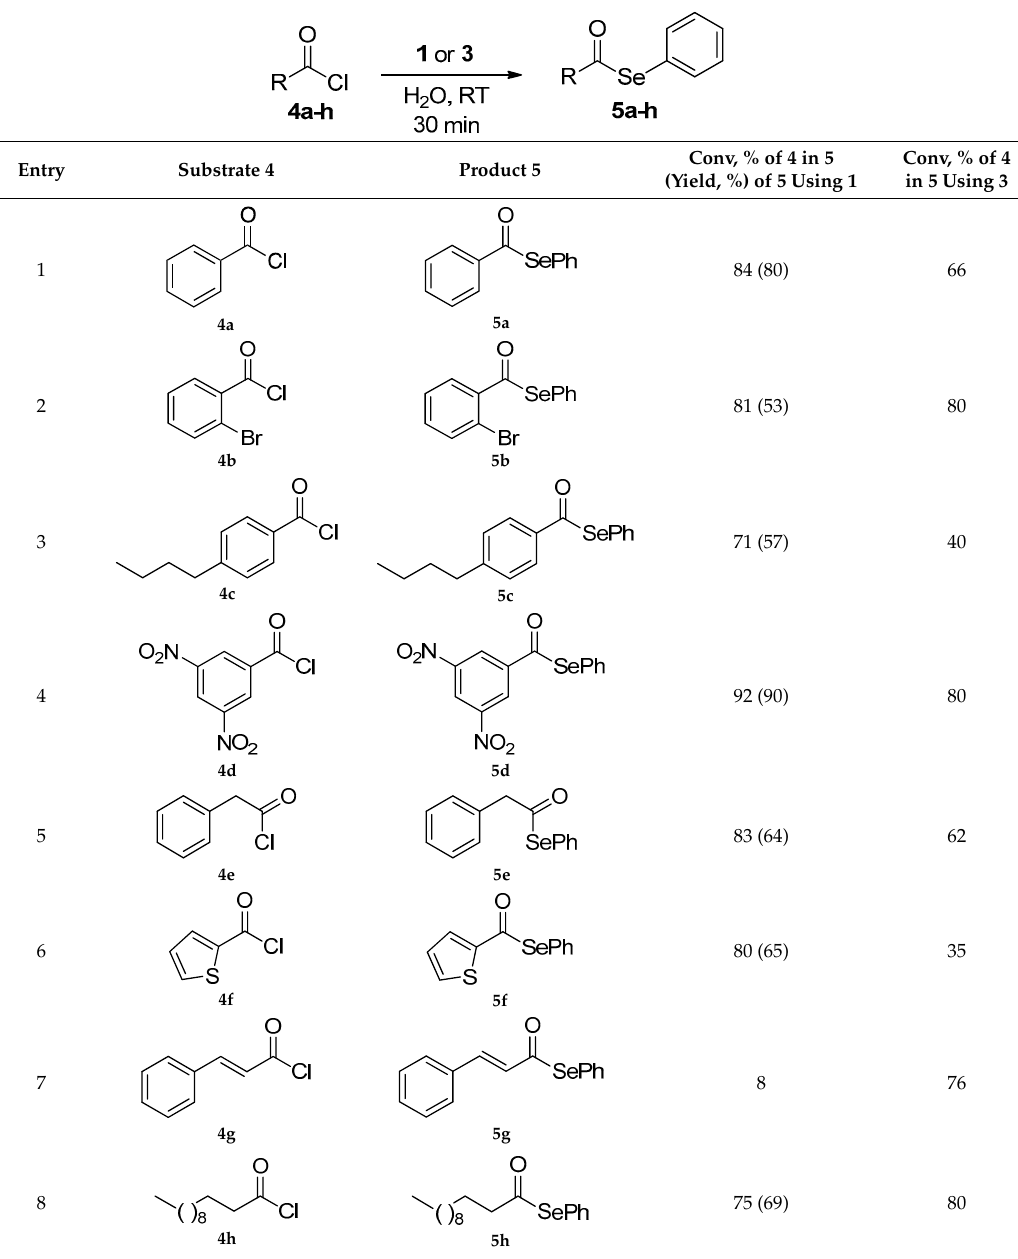
Table 3. Synthesis of selenol esters 5 .